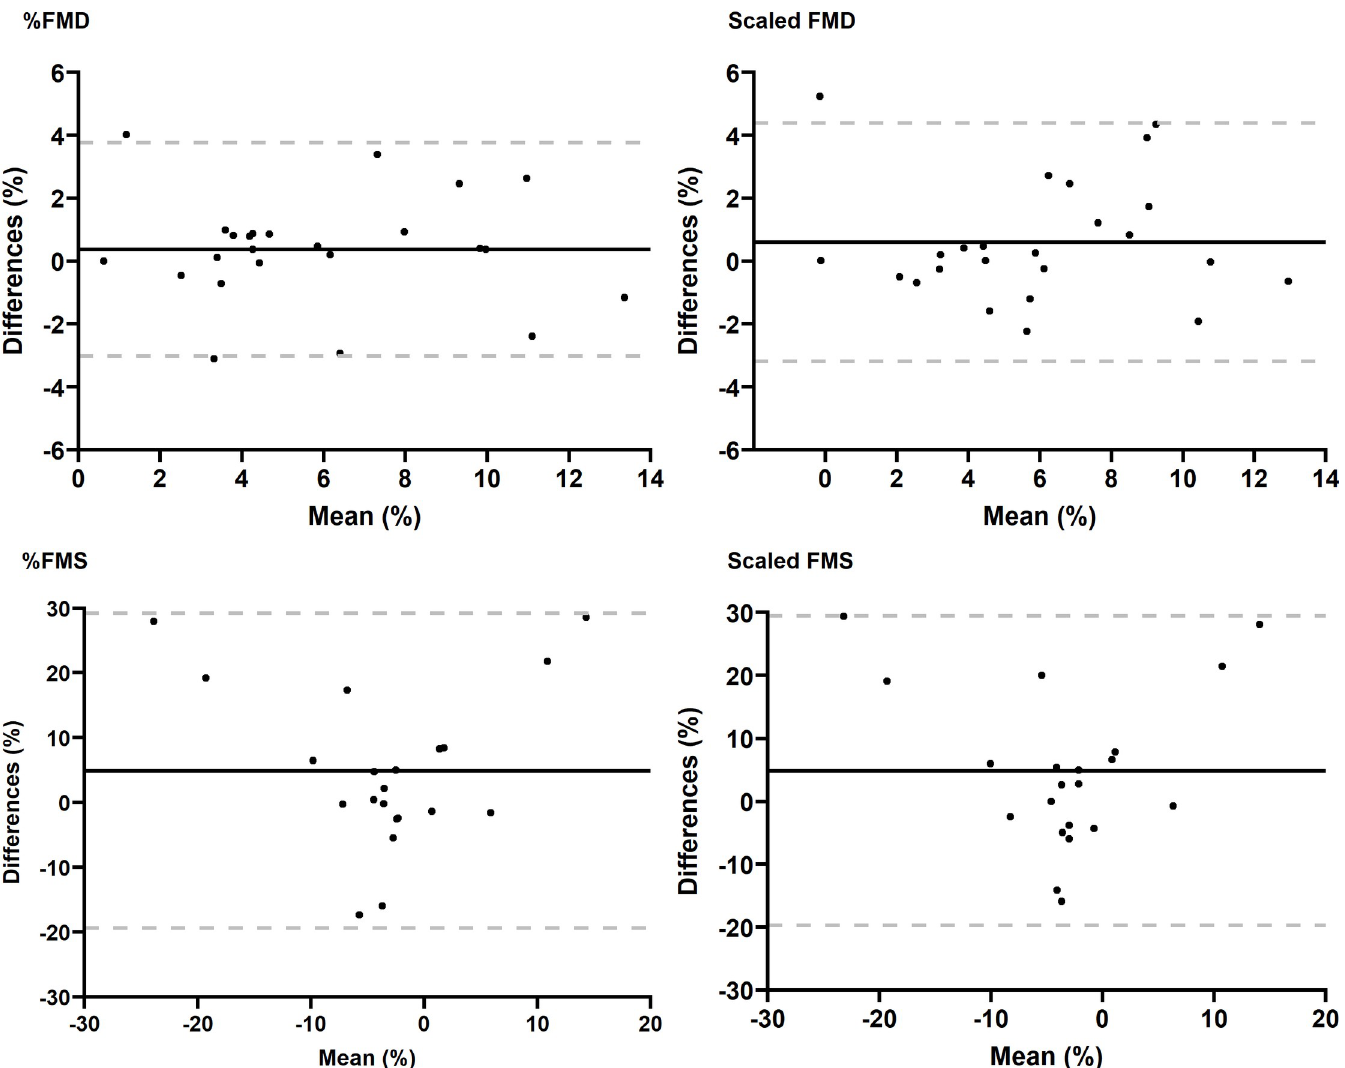
Fig 1. Bland-Altman plots for intra-day FMD and FMS measurements. Y-axis represents the difference between the first and second measures; the dashed grey lines correspond to the 95% LOA and the black line represents the mean of the differences. For %FMD, the lower LOA was– 3.02% (95% CI: - 4.29 to– 1.76); and the upper LOA was 3.75% (CI: 2.48 to 5.01); for scaled FMD, the lower LOA was—3.19% (95% CI: - 4.614 to -1.78); and the upper LOA was 3.99% (95% CI: 2.57 to 5.40); for % FMS, the lower LOA was—19.38% (95% CI: -28.45 to -10.32) and the upper LOA was 29.19% (CI of 20.13 to 38.26); for the scaled FMS, the lower LOA was -18.92% (95% CI: - 27.13 to– 10.71); and the upper LOA was 29.67% (95% CI: 21.45 to 37.87). FMS data were missing in 3